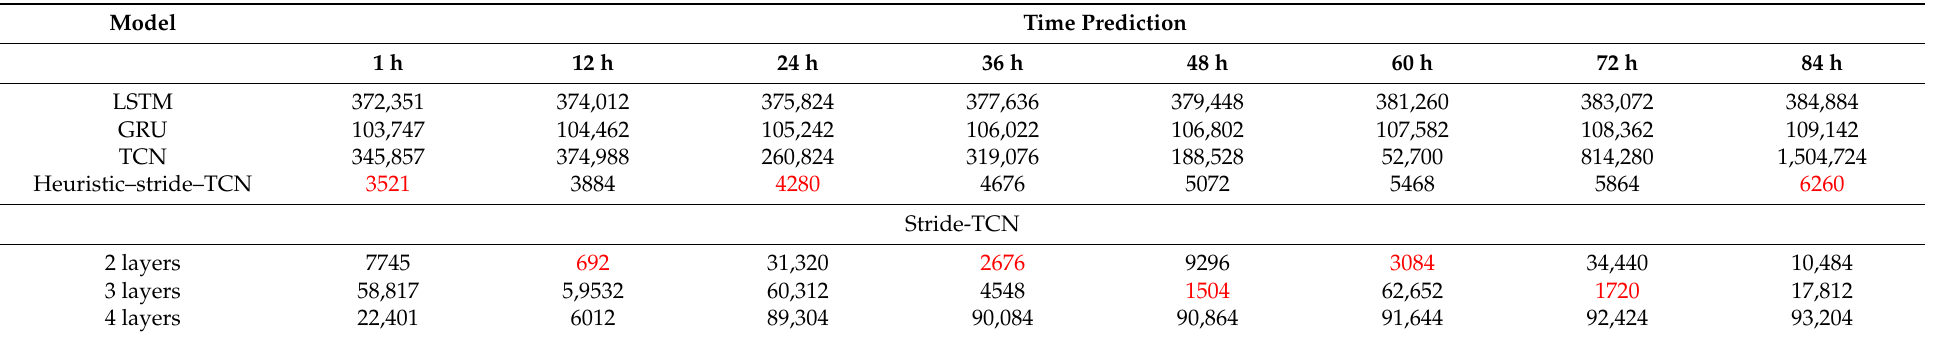
Table 10. Models’ complexity in Spain dataset (dataset 2), demonstrated by the number of